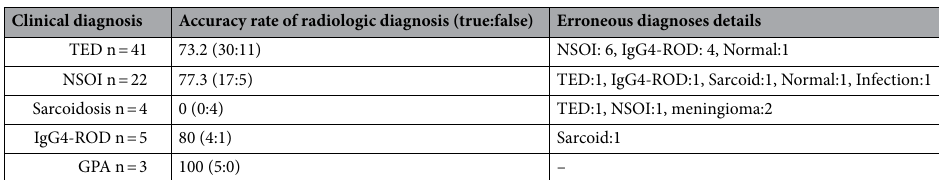
Table 2. Accuracy rate of radiologic diagnosis for various orbital inflammatory diseases. TED thyroid eye disease, NSOI non-specific orbital inflammation, IgG4-ROD IgG4-related ophthalmic disease, GPA Granulomatosis with